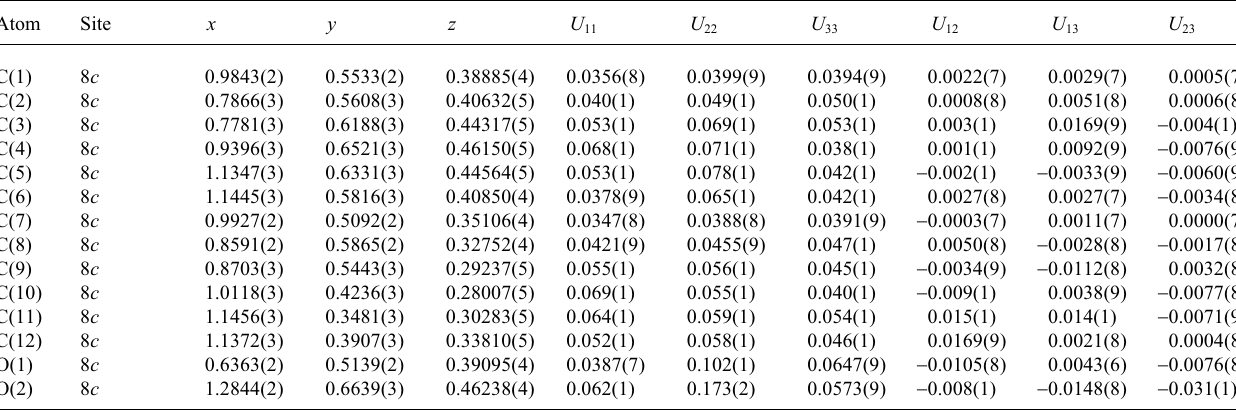
Table 3. Atomic coordinates and displacement parameters (in Å 2